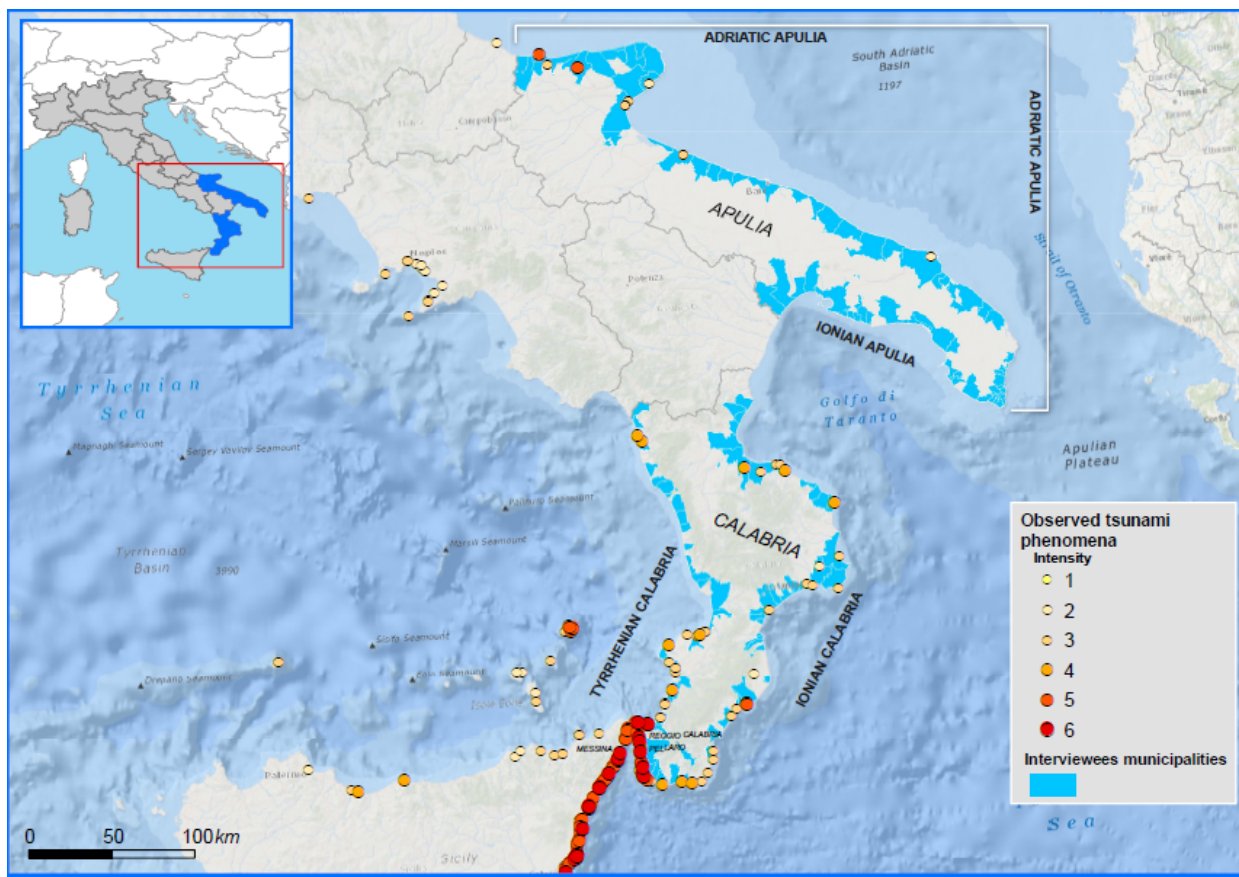
Figure 2. Geographical distribution of interviewees’ municipalities (light blue areas), with points of tsunami observations (circles). The circles’ colour is proportional to the tsunami intensity (see legend). Data, including intensity classes, are from Maramai et al.